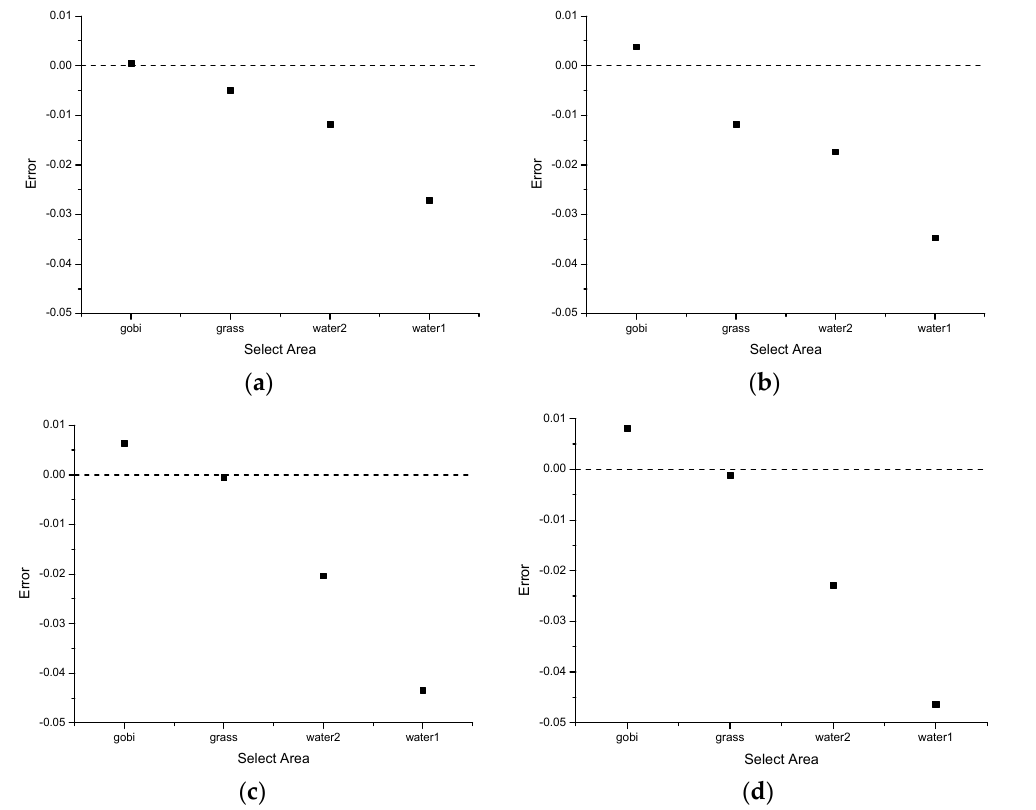
Figure 15. Comparison of absolute difference of ground reflectance in different areas obtained by PRSS-1 using RCRII model and Sentinel-2 using reflectance inversion model; ( a – d ) show blue, green, red, and NIR bands.